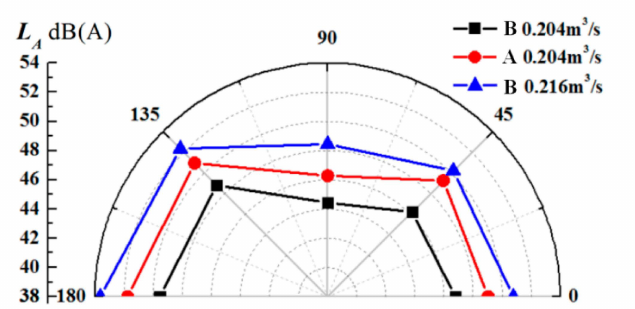
Figure 9. Comparison of inlet noise of different blade models at high-efficiency working condition (including two rotating